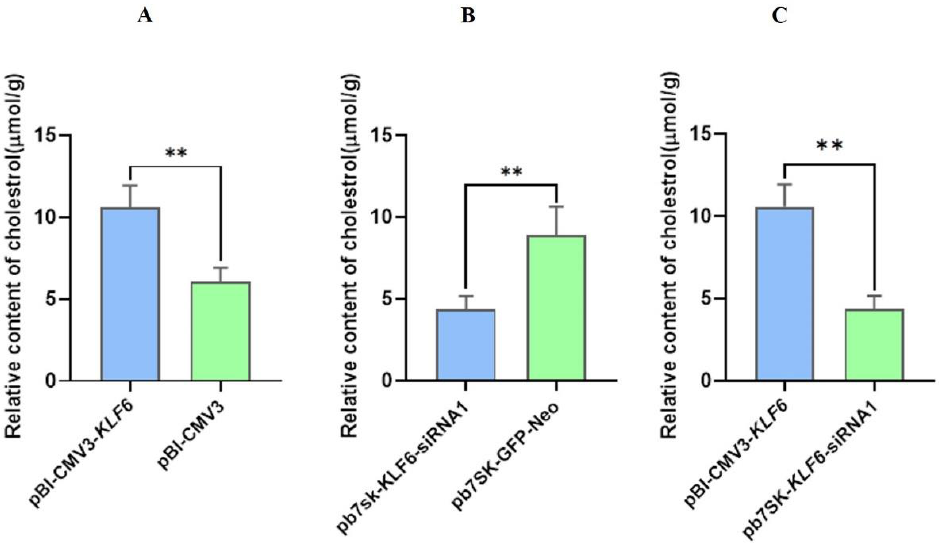
Figure 10. Cholesterol content in BMECs after KLF6 overexpression and down-regulation ( A ) Rela- tive contents of cholesterol in BMECs transfected with pBI-CMV3- KLF6 and pBI-GFP-Neo-CMV3. ( B ) Relative contents of cholesterol in BMECs transfected with pb7SK- KLF6 -siRNA1 and pb7SK- GFP-Neo. ( C ) Relative contents of cholesterol in BMECs transfected with pBI-CMV3- KLF6 and pb7SK- KLF6 -siRNA1. ** p <